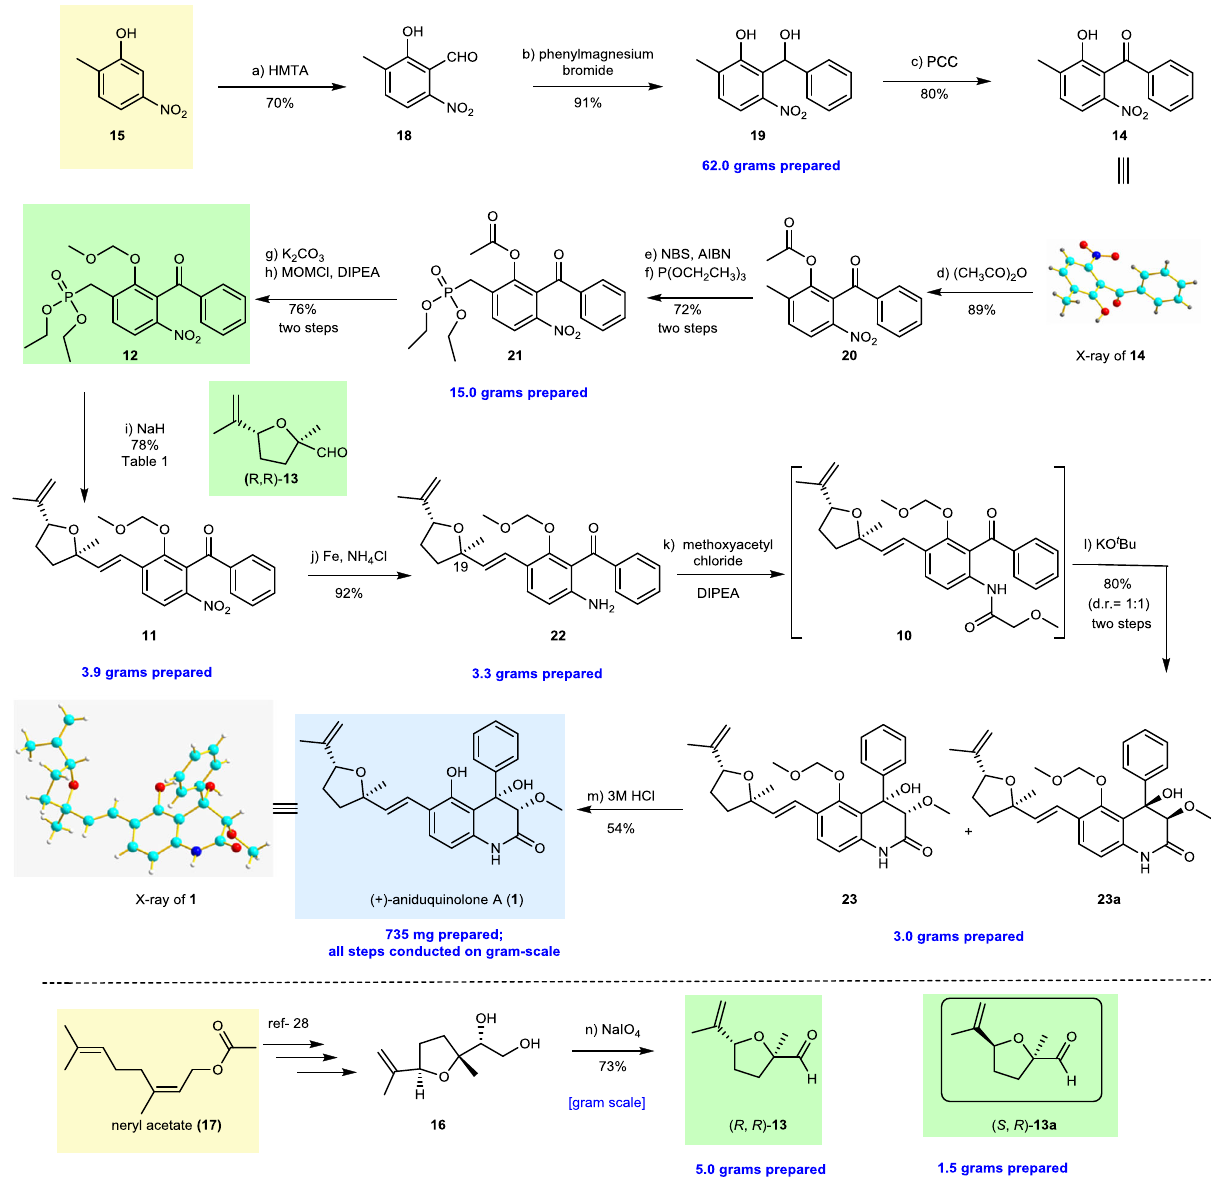
Fig. 3 Total synthesis of ( + )-aniduquinolone A (1). Reagents and conditions: a HMTA (1.2 equiv), TFA, 90 °C, 12 h, 70%; b phenylmagnesium bromide (2.0 equiv), THF, − 20 °C, 2 h, 91%; c PCC (1.0 equiv), CH 2 Cl 2 , 0 °C, 4 h, 80%; d H 2 SO 4 , (CH 3 CO) 2 O/CH 2 Cl 2 (1:2), 0 °C to rt, 12 h, 89%; e NBS (1